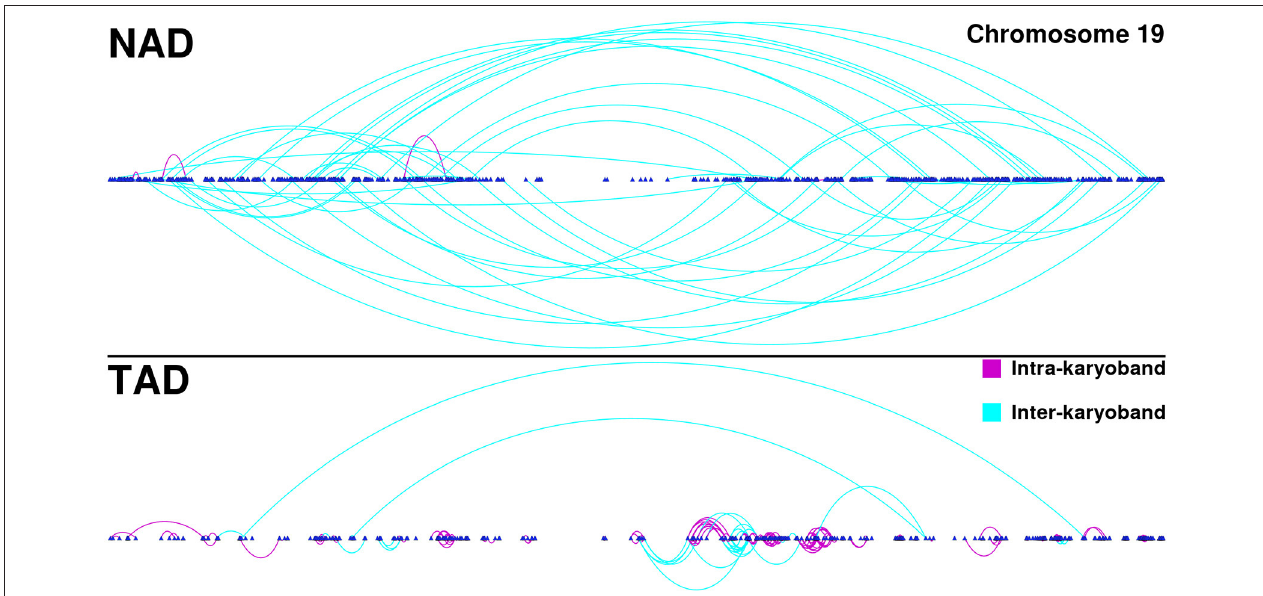
FIGURE 3 | Chromosome 19 gene co-expression networks (GCNs) for NAD and TAD. In this figure, cis- interactions for NAD (top) and TAD (bottom) are depicted. Genes are placed according to its starting base pair. Turquoise links join genes from different cytobands, meanwhile purple interactions take account for intra-cytoband relationships.